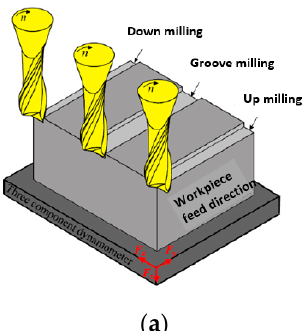
Figure 4. ( a ) Schematic of micro-channel machining [47], ( b ) formation of burrs [76] and ( c ) deflection of micro-tool [75]. Copyright granted by Elsevier and Optica Publishing Group.